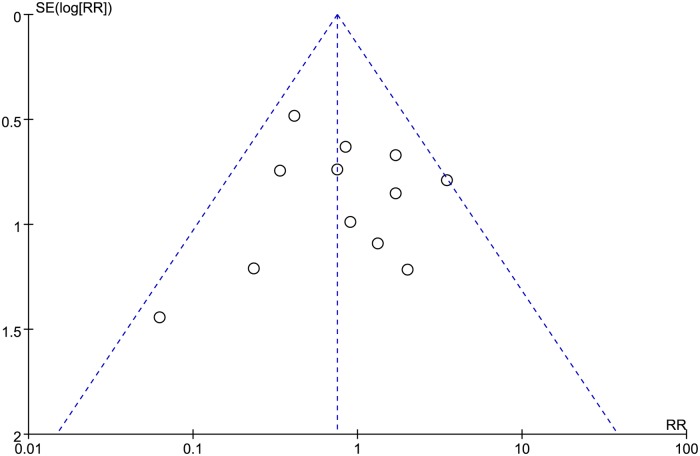
Funnel plot of reherniation rate.